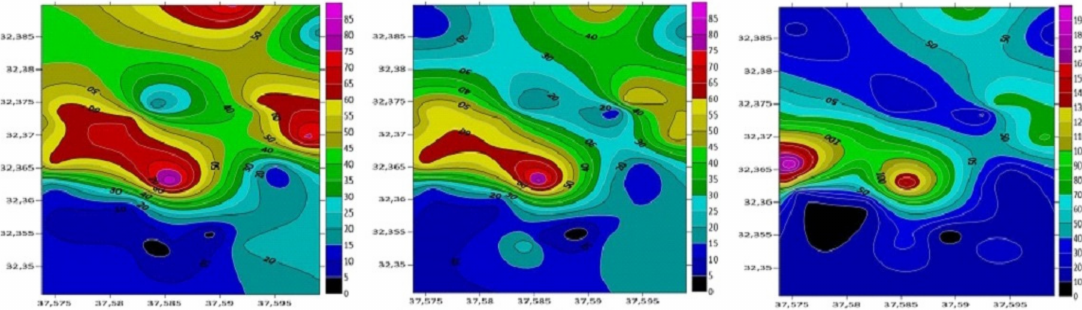
Figure 4. Surfer map of PM 10 values ( µ g/m 3 ) measured in the evening (Concentration, Average,